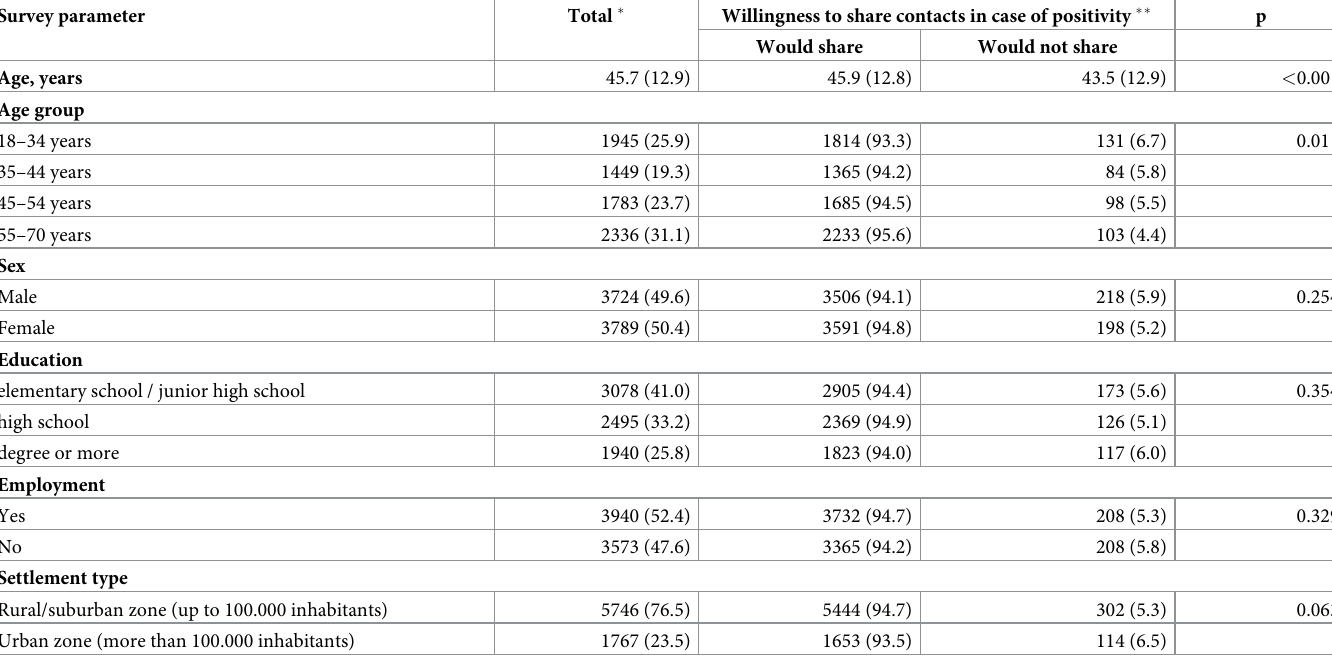
Table 1. Demographic and social characteristics of the survey participants (n = 7513) according to the attitude for willingness to share contacts in case of positivity. Survey parameter